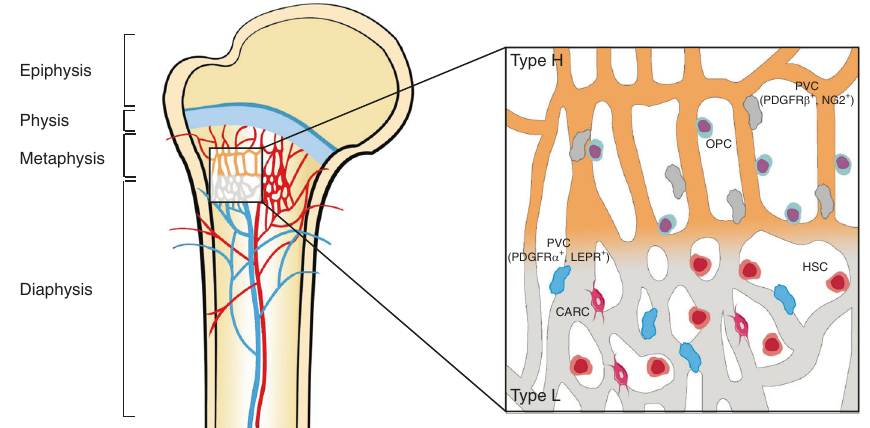
Fig. 2 Endothelial cell heterogeneity of bone vessels. Distinct capillary subsets with high heterogeneity in the skeletal system can be subdivided into type H and type L endothelium based on morphology, specialization, molecular identity, and functional properties. Type H vessels are primarily distributed around the endosteum region and metaphysis close to the growth plate. They are linearly arranged with distinctive columnar structures and interconnected with new anastomotic loop-like arches at the distal edge. Type L vessels are located with highly branched networks in the bone marrow region of the diaphysis. Type H capillaries are selectively surrounded by Runx2 + , collagen 1 α + , and Osterix-expressing osteoprogenitors, as well as PDGFR β - and NG2-expressing perivascular cells. Type L capillaries are predominantly in fi ltrated by PDGFR α - and LEPR-positive cells as well as CAR cells, which interact with HSCs in the regulation of hematopoiesis. Arteries branch into smaller arterioles and fl ow into type H vessels in the region of the metaphysis near the growth plate. They then converge into a type L sinusoid network at the interface of the diaphysis and are terminally drained via veins located in the contiguous medullary